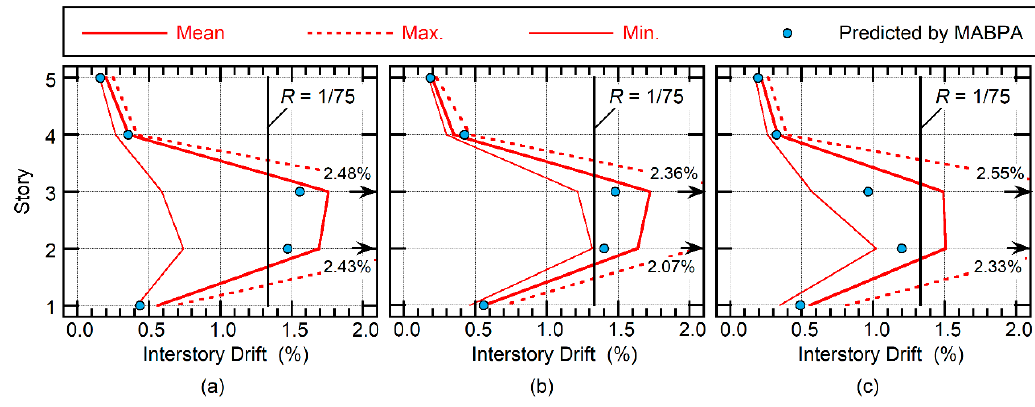
Original image of Figure 23: